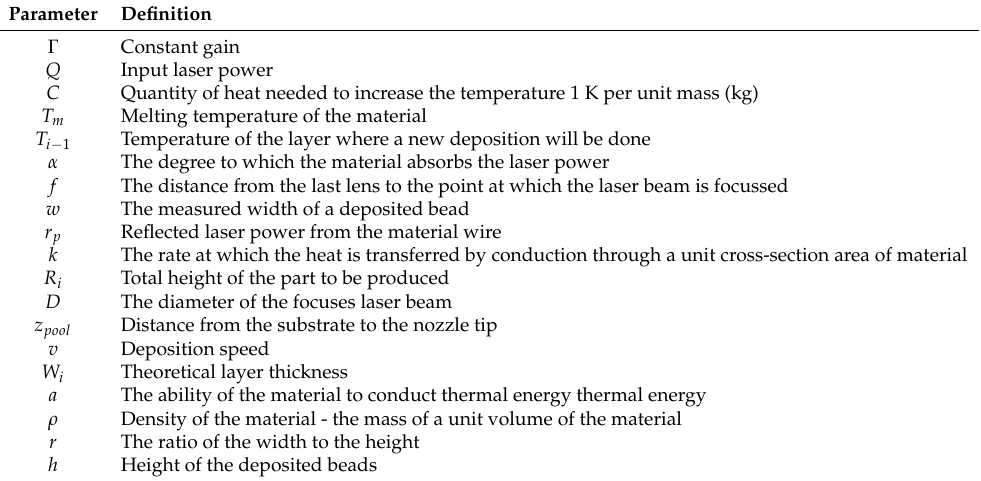
Table 3. Summary of the definition of the